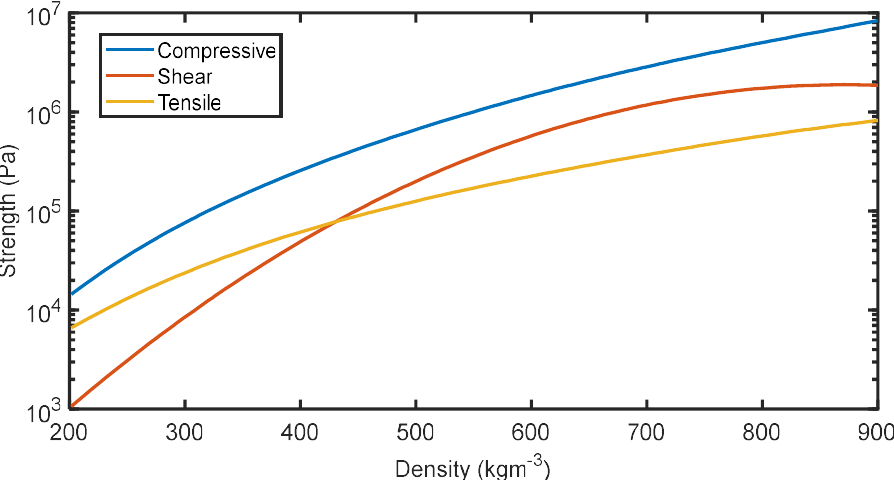
Figure 5. Strength of snow and firn ice as a function of density; adapted from [48,49]. Note that the experimental data scatter significantly around the average curves shown here.